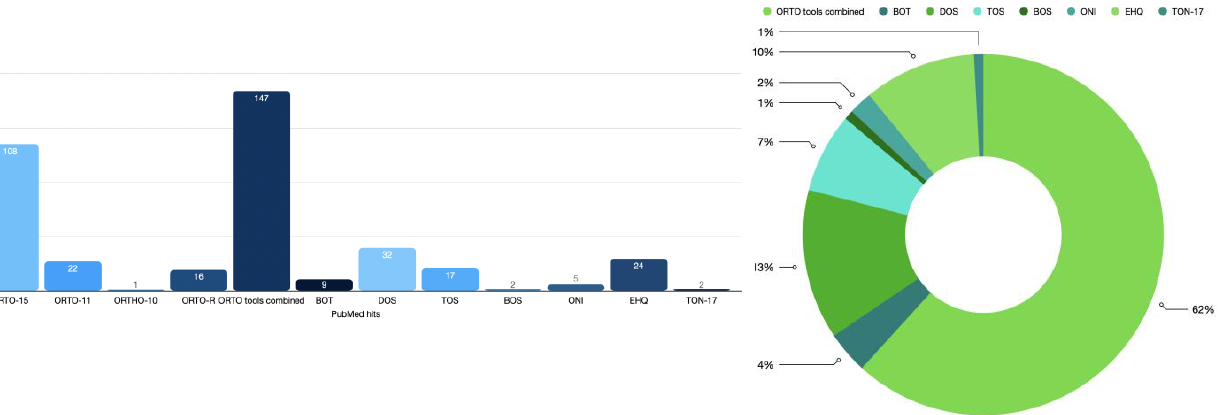
Figure 1. Absolute number (left) and percent (%, right) of the PubMed hits regarding the tools used for the assessment of ON (Accessed on 3 March 2023). BOS: Barcelona Orthorexia Scale; BOT: Bratman Orthorexia Test; DOS: Düsseldorf Orthorexia Scale; EHQ: Eating Habits Questionnaire; ON: Orthorexia nervosa; ONI: Orthorexia nervosa inventory; ORTO combined: includes the ORTO-15, ORTO-11, ORTHO-10, and the ORTO-R; TOS: Teruel Orthorexia Scale; TON-17: Test of Orthorexia Nervosa.